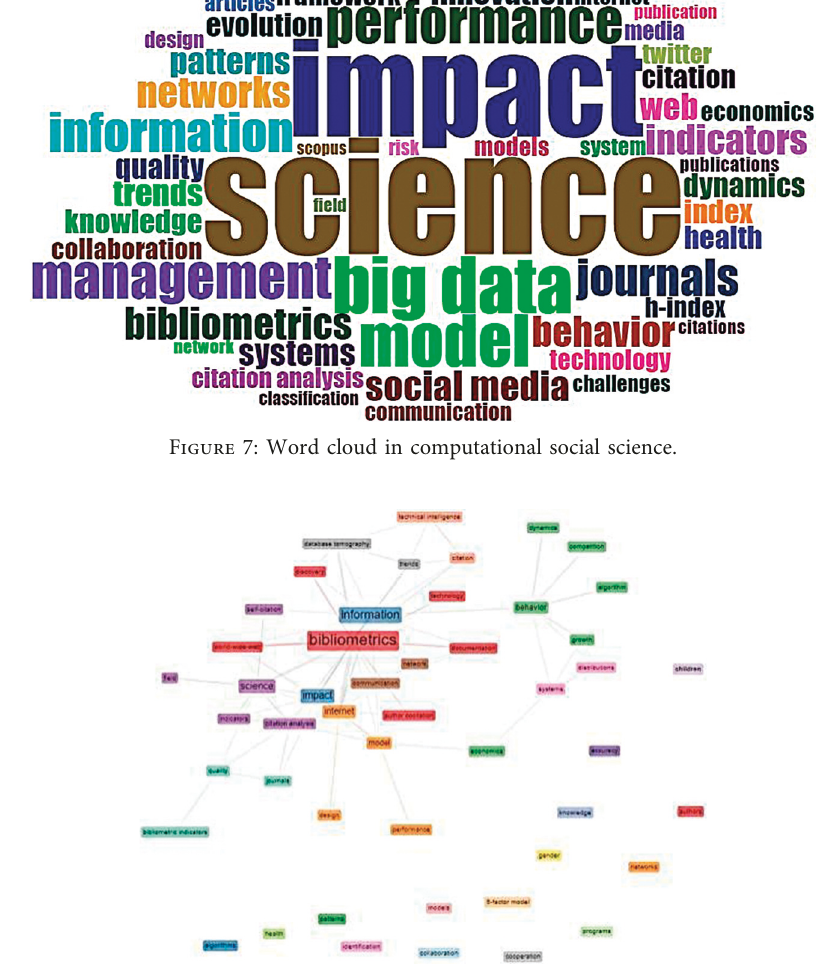
Figure 8: 2001–2005 cooccurrence network.